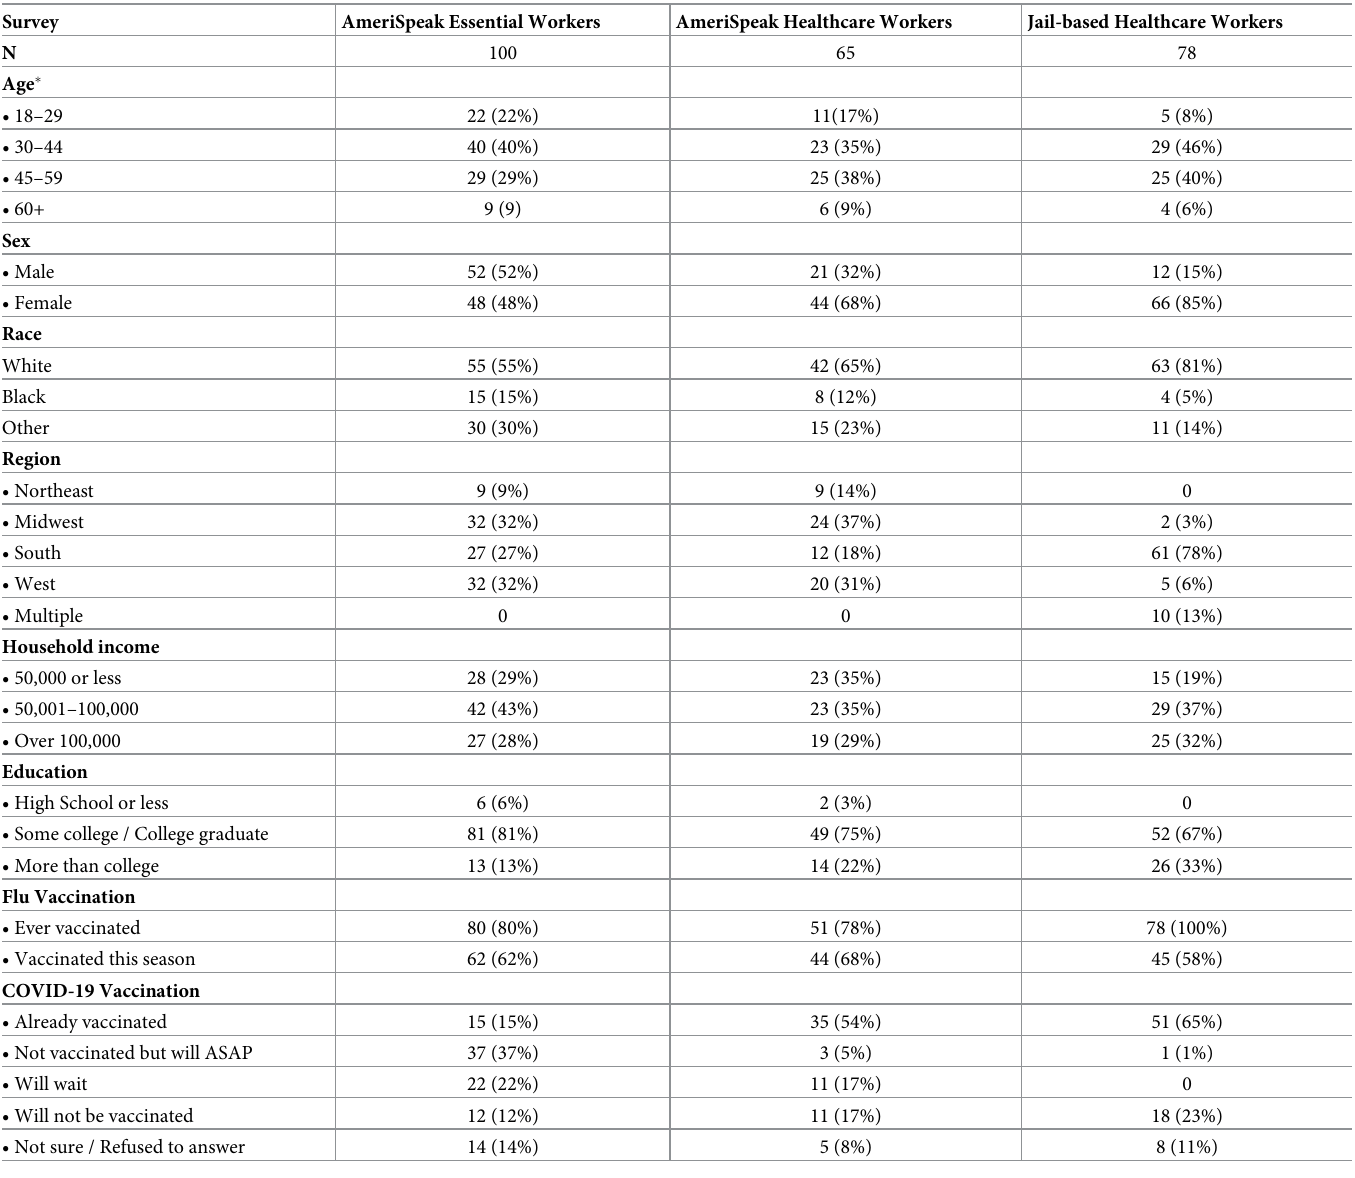
Table 1. Sample characteristics and vaccination